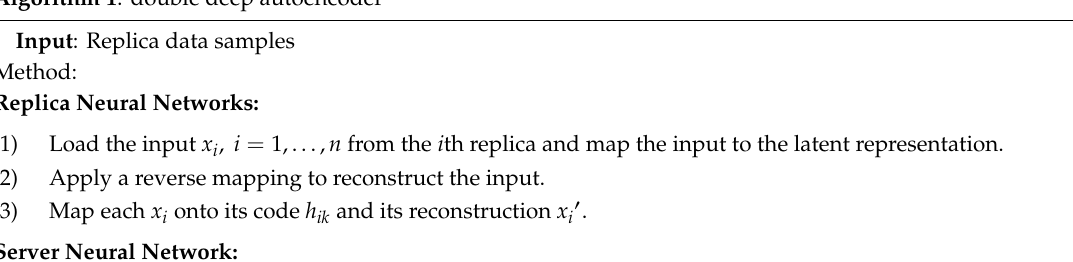
Algorithm 1 : double deep